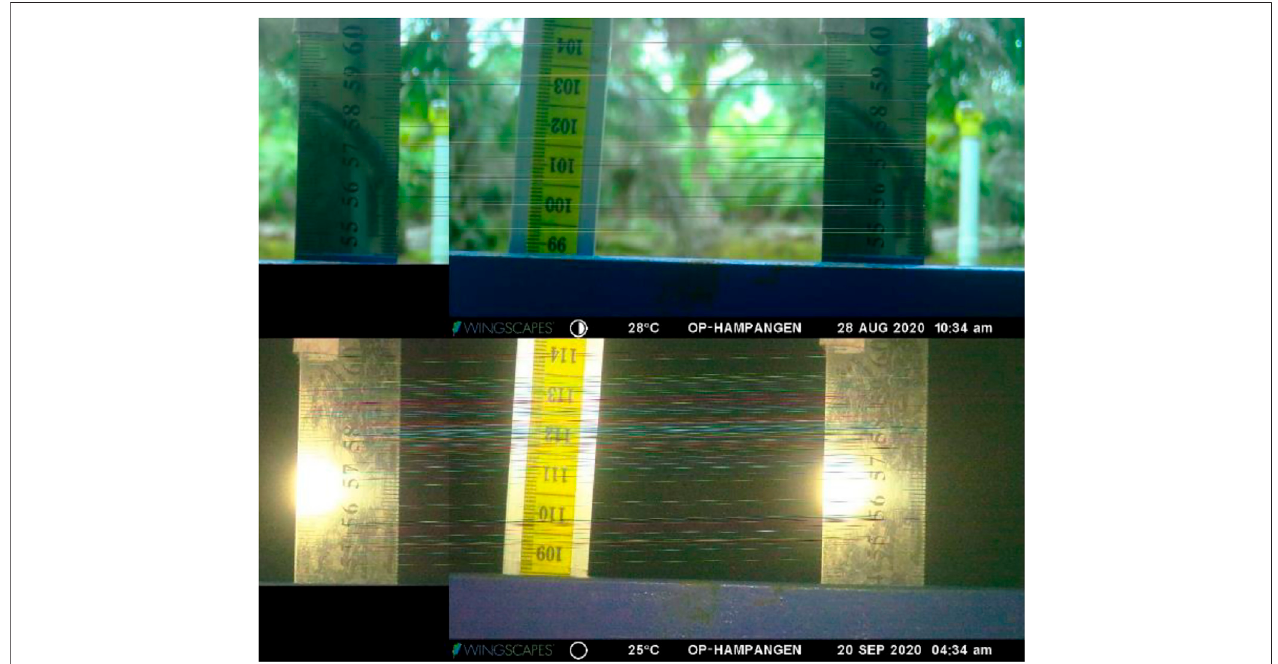
FIGURE 6 | Examples of image processing for daytime and night-time images at the Hampangen Oil Palm site. Ruler in image on right is compared to reference image on left, containing the cropped region of interest with potential keypoints (central scale is the water table gauge). Colored lines represent individual matches between keypoints, which are used to calculate vertical